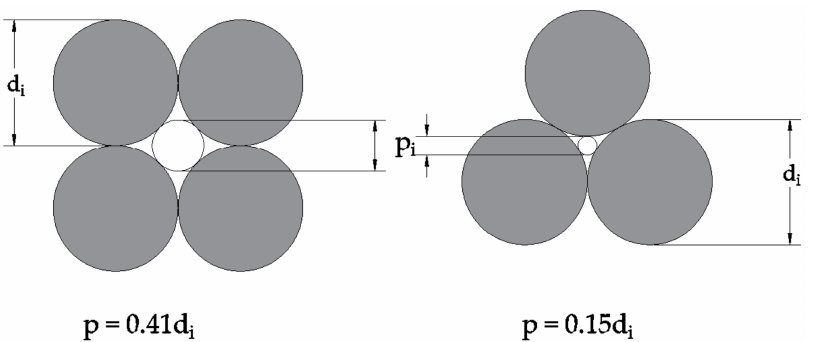
Figure 1. Maximum pore diameter (p) created between particles for a mean diameter (d i ), adapted from